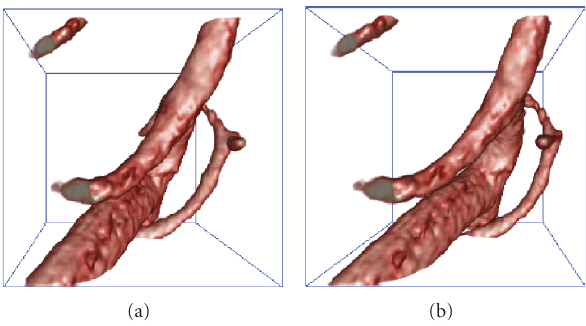
Figure 6: The same scene rendered from the most left and most right view points.